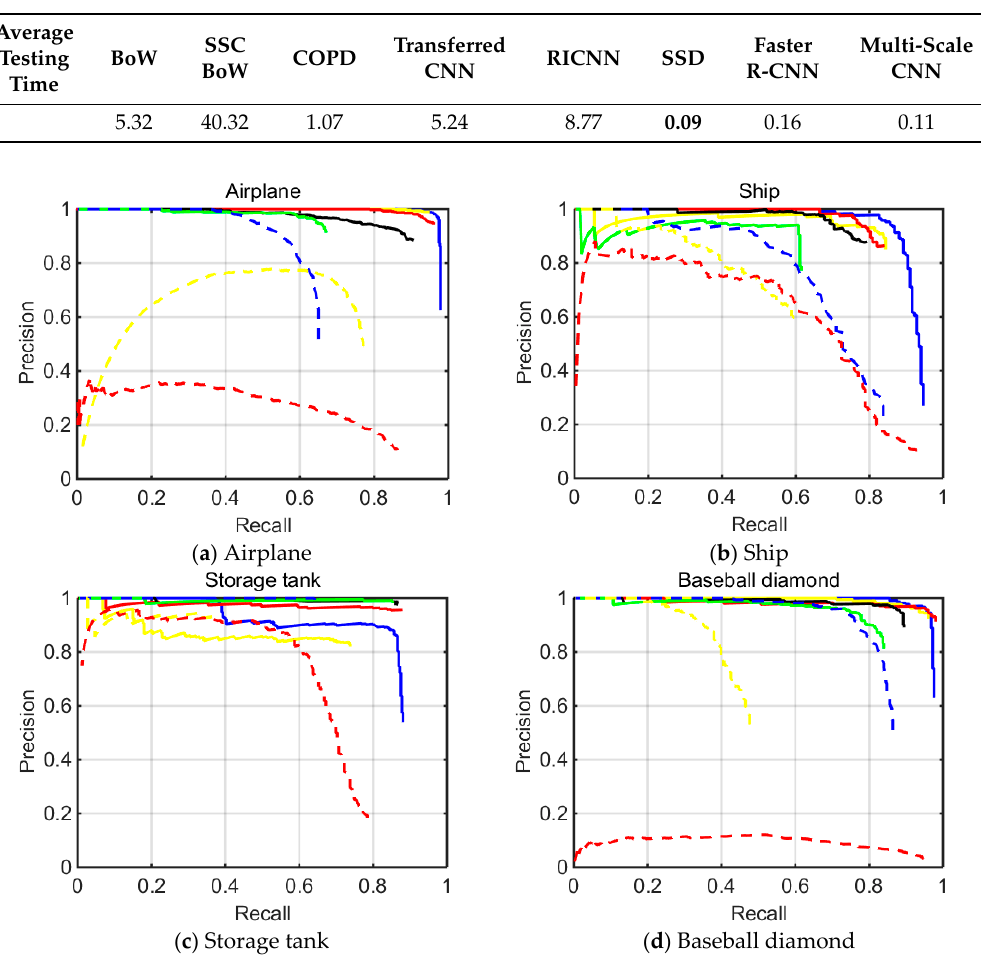
Table 5. The average testing time of the eight object detection